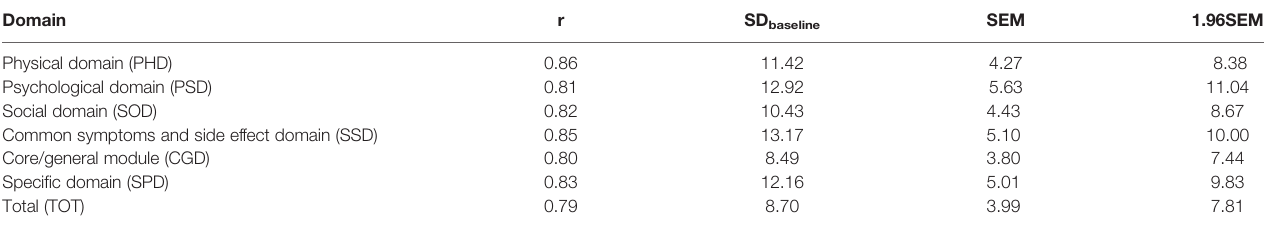
TABLE 5 | The MCID value of QLICP-BR (V2.0) determined by SEM (n = 246). Domain